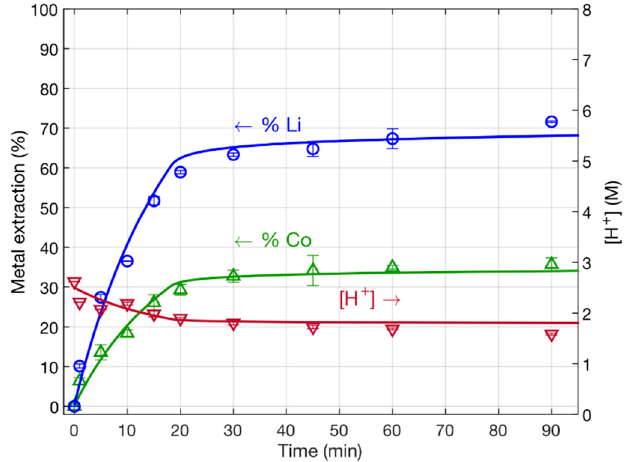
Figure 4. Experimental (marks) and simulation (lines) results for S/L = 50 g/L in 2.5 M HCl.